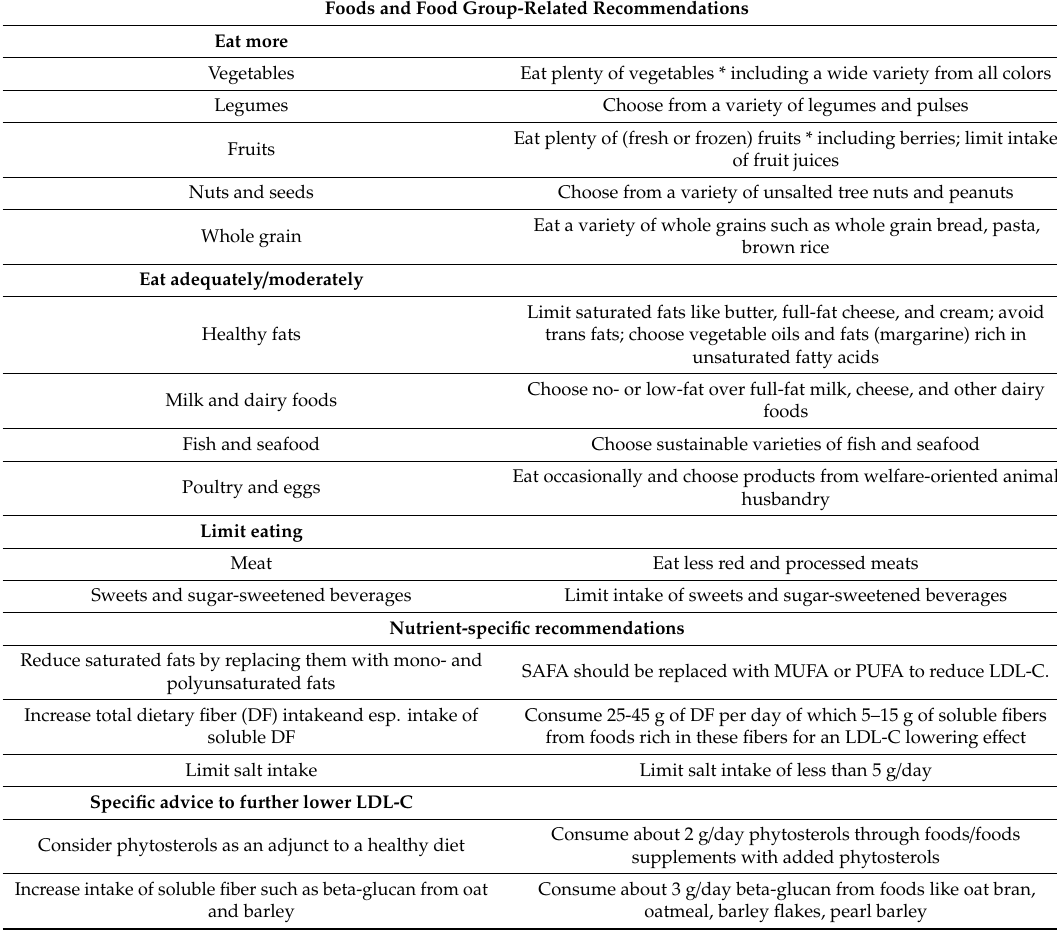
Table 3. Characteristics of a predominantly plant-based healthy diet for management of dyslipidemia and CVD